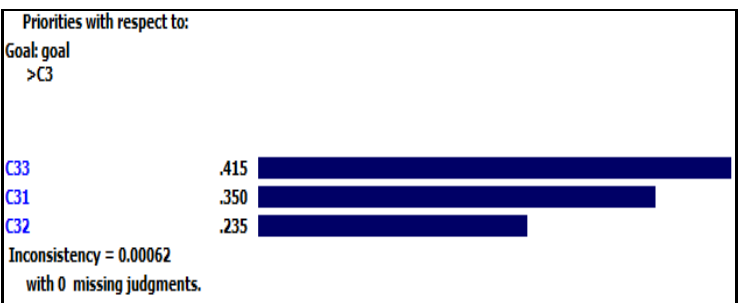
Fig. 6. Weights of smart marketing sub-criteria.